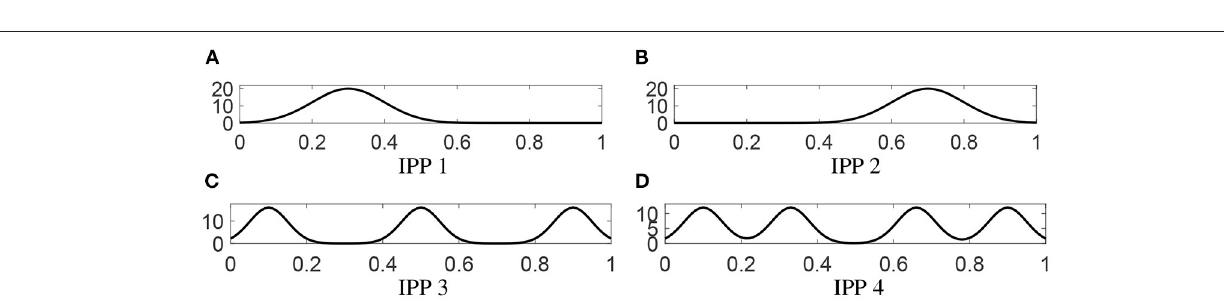
FIGURE 6 | Intensities of four inhomogeneous Poisson processes. (A) The intensity of the first IPP. (B–D) Same as (A) except for the other three processes,